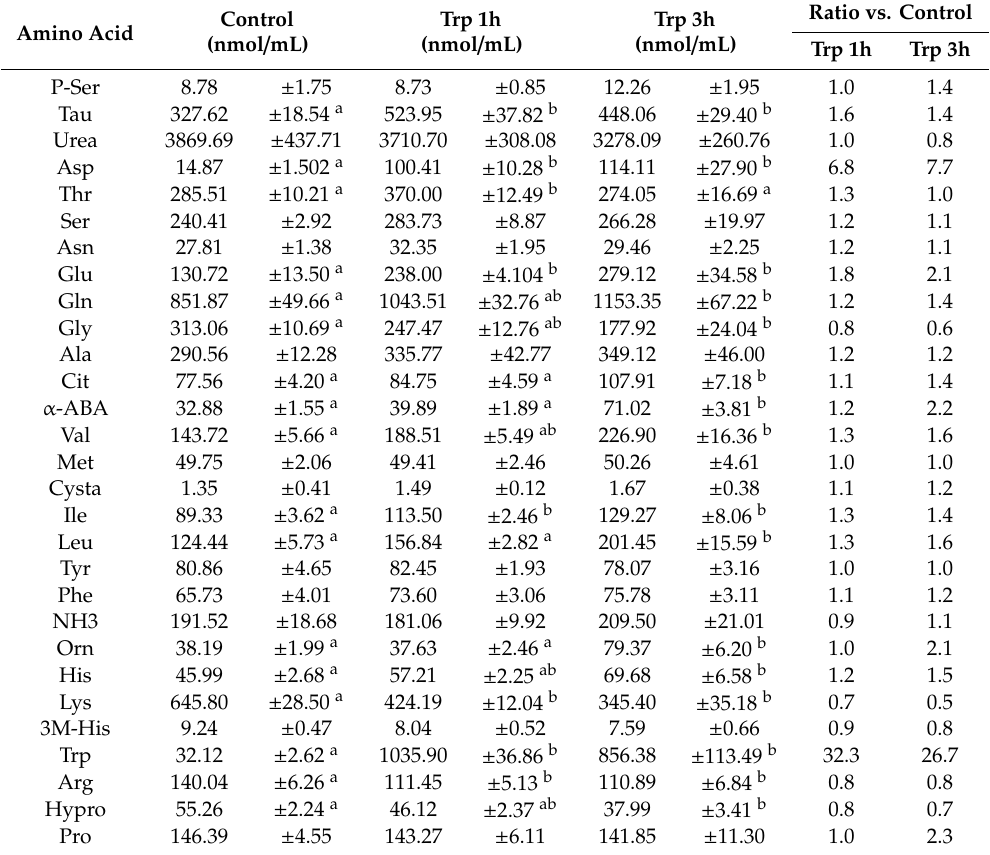
Table 1. Serum amino acid concentrations in rats administered Tryptophan